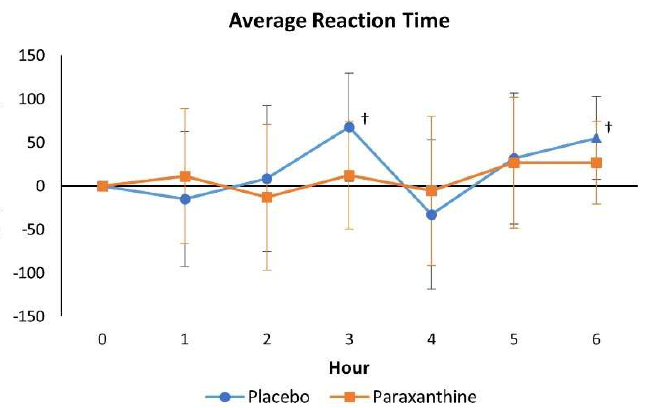
Figure 6. Mean changes with 95% confidence intervals in absent and present reaction times. † rep- resents p < 0.05 change from baseline